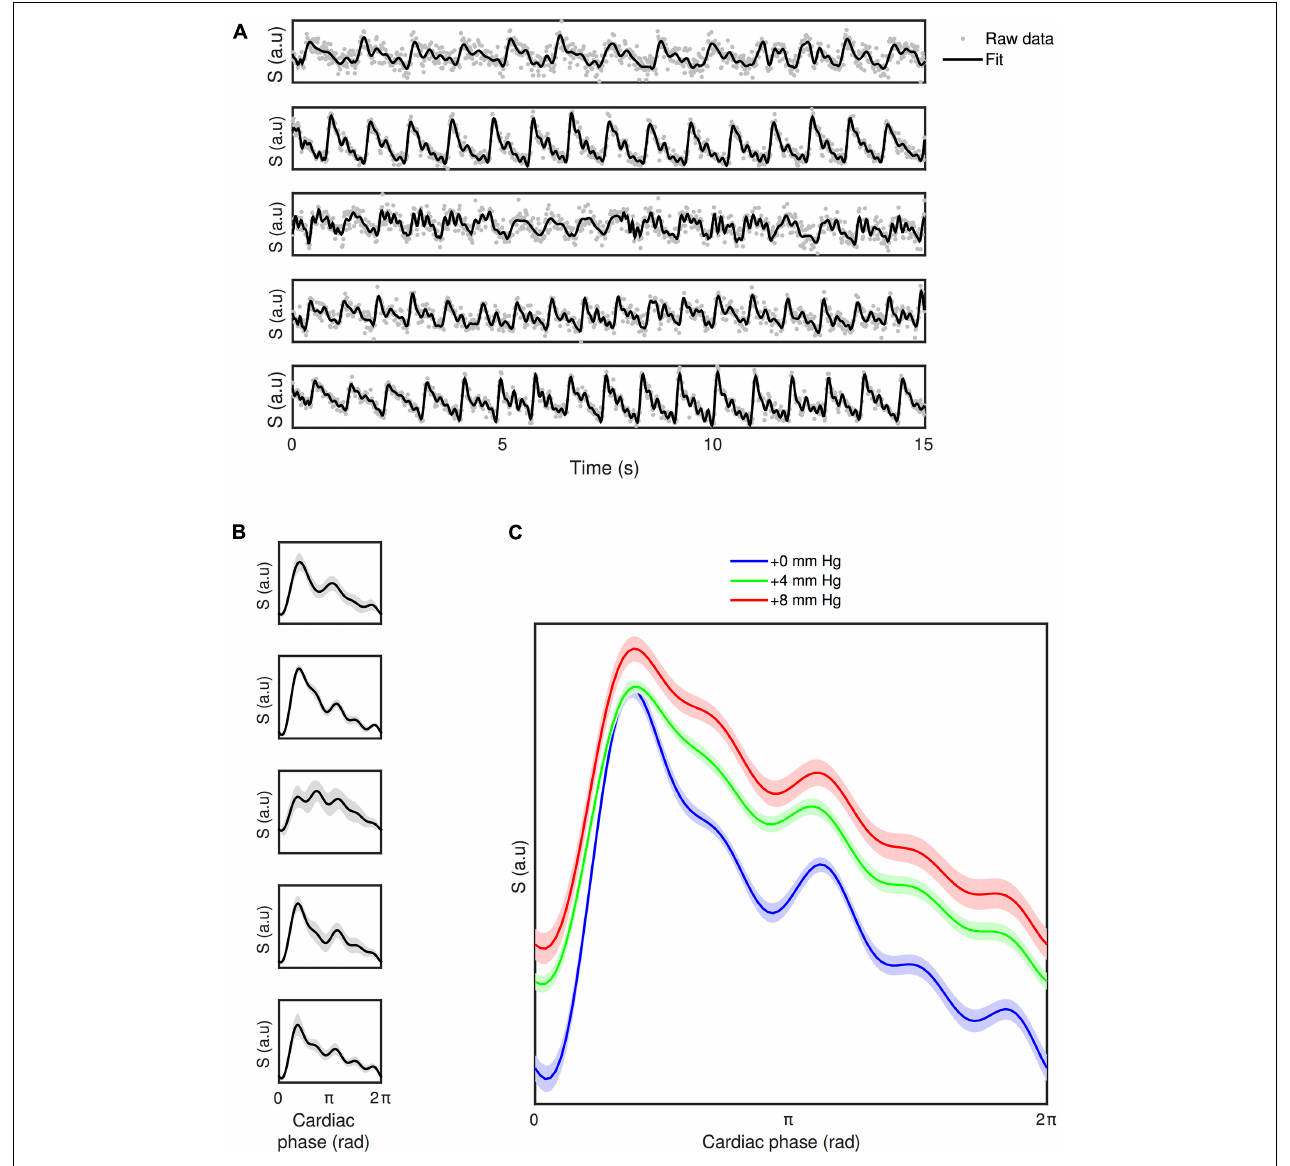
FIGURE 6 | (A) First 15 s of time series for each subject for HC-challenge data (TR15 and HC0 condition), with beat-to-beat fit overlaid. (B) The mean pulsatile waveform ( ± SD shaded area) for each subject (TR15 and HC0 condition). (C) The across subject mean pulsatile waveforms ( ± within subject error shaded area) for each HC condition of the HC-challenge. Qualitatively one can see the pulsatile waveform shape is modulated by hypercapnia.